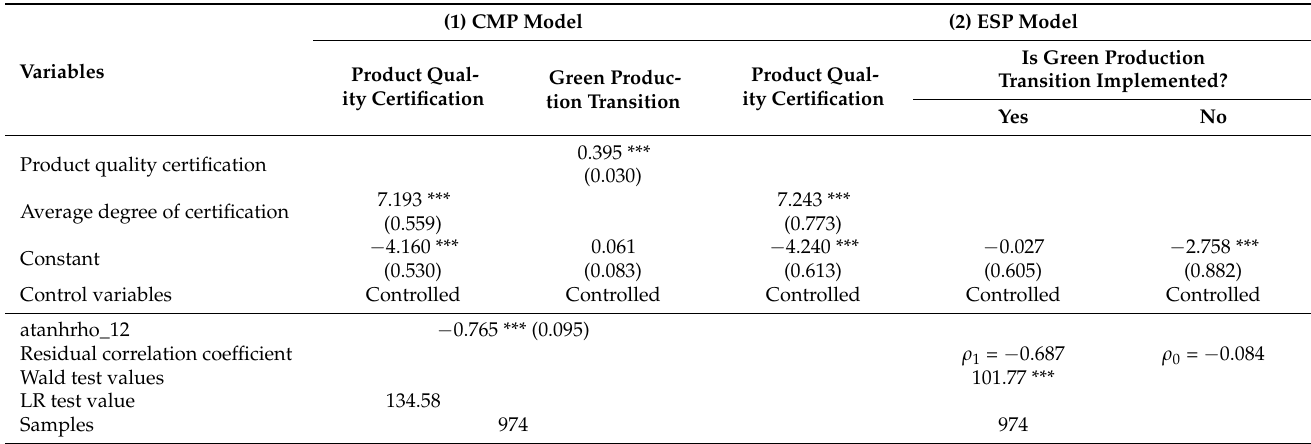
Table 4. Estimation results of endogeneity